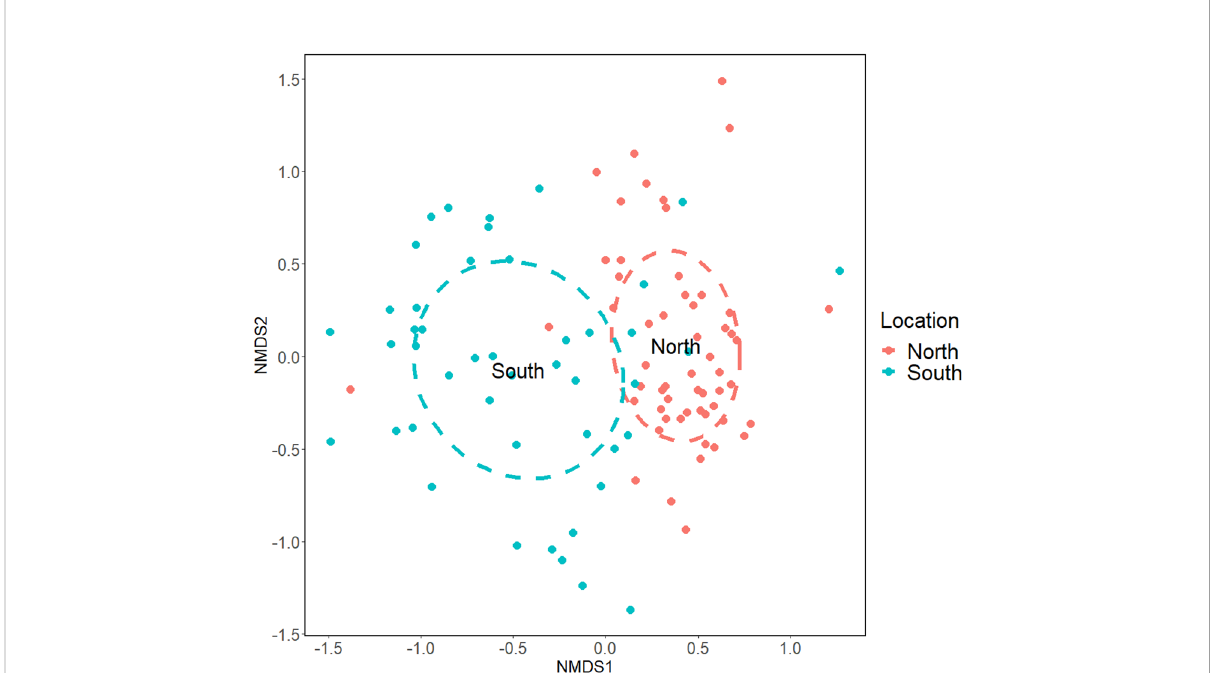
FIGURE 3 Non-metric Multidimensional Scaling of Venice Lagoon fi sh communities by sites, according to eDNA metabarcoding. Graph produced starting with a Bray-Curtis distance matrix calculated from the normalized OTU table. Southern lagoon samples (Chioggia) are indicated in blue and northern lagoon samples (Torcello) in red (k = 3; Stress =